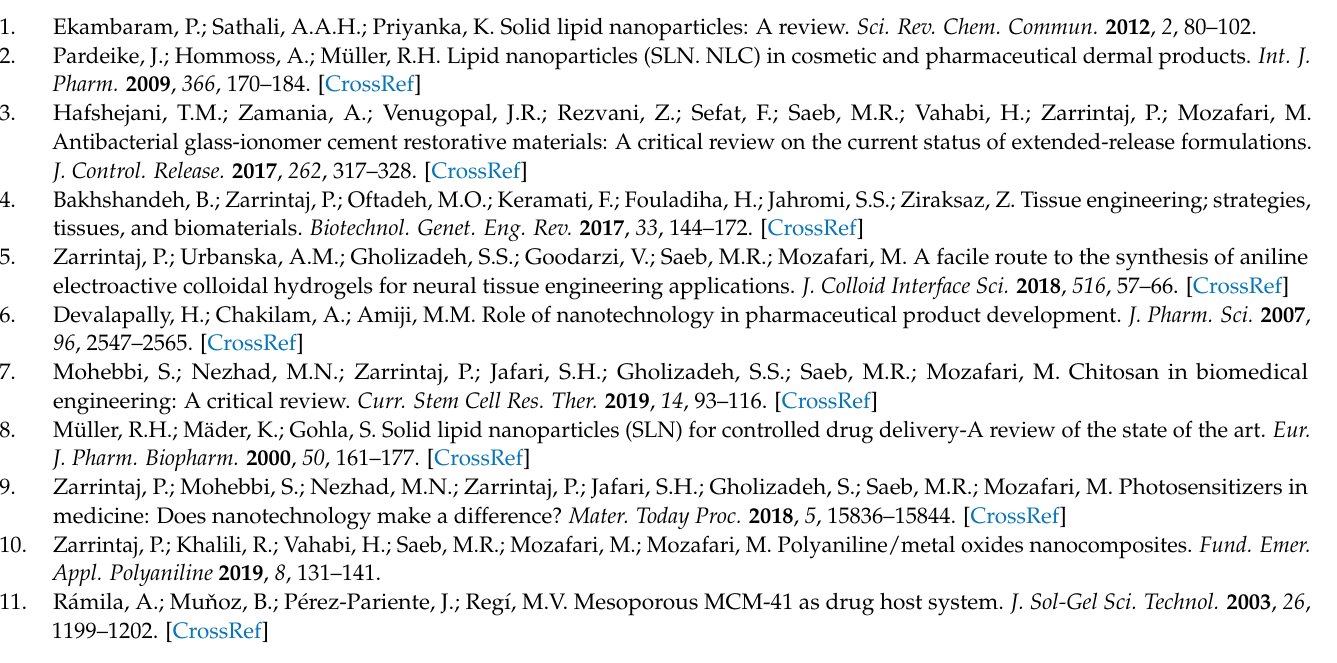
curcumin application. Table S3: Final pH vs. initial pH for commercial materials. Figure S1: Nitrogen adsorption/desorption isotherms for hierarchical zeolites: FAU/CTABr (A), FAU/Brij (B) and FAU/Lutrol (C) derived from FAU-type commercial zeolite. Adsorption and desorption points are represented by closed and open circles. Note that for mesopores with diameters below 4–5 nm both adsorption and desorption branches coincide. Figure S2: FTIR spectra in the wavenumber range from 600 cm − 1 to 4000 cm − 1 of hierarchical materials based on commercial FAU zeolite (panel A) and these materials modified with curcumin (panel B). The enlarged portion corresponding to the range from 3000 cm − 1 to 3800 cm − 1 is shown at the top of each panel. Figure S3: TEM images